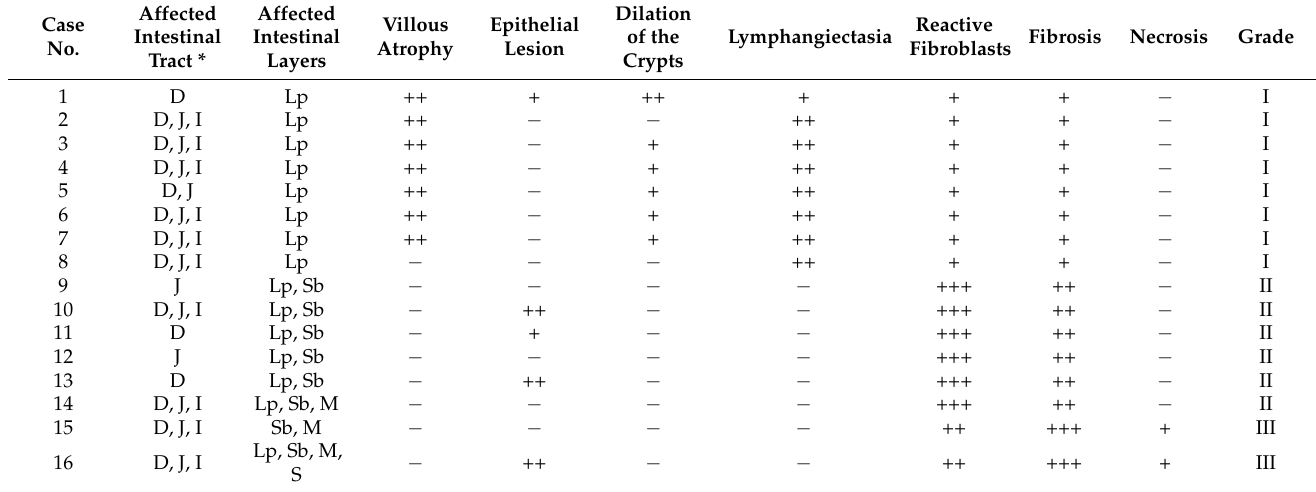
Table 5. Results of the histopathological evaluation and stage. Relation between the morphologic parameters with the affected layers and the grade of FGESF.